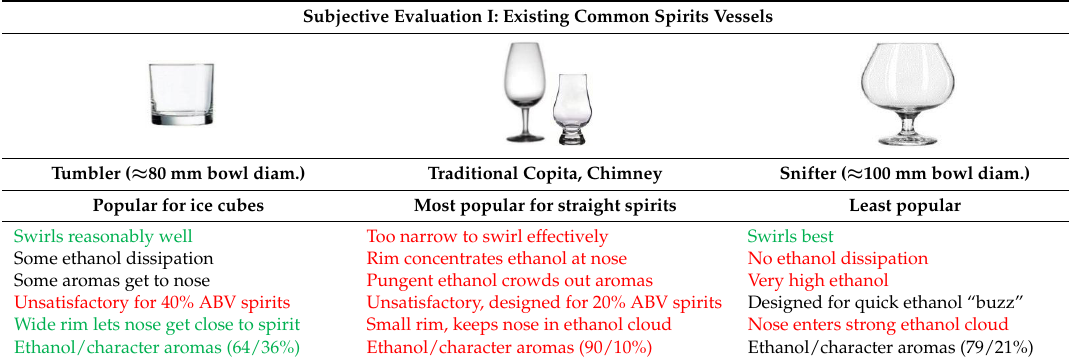
Table 2. Comparison of best (green) and worst (red) nosing vessel attributes. Consensus of viability as a diagnostic vessel for three common vessel designs. Details in Section 2 Methods. Subjective Evaluation I: Existing Common Spirits Vessels